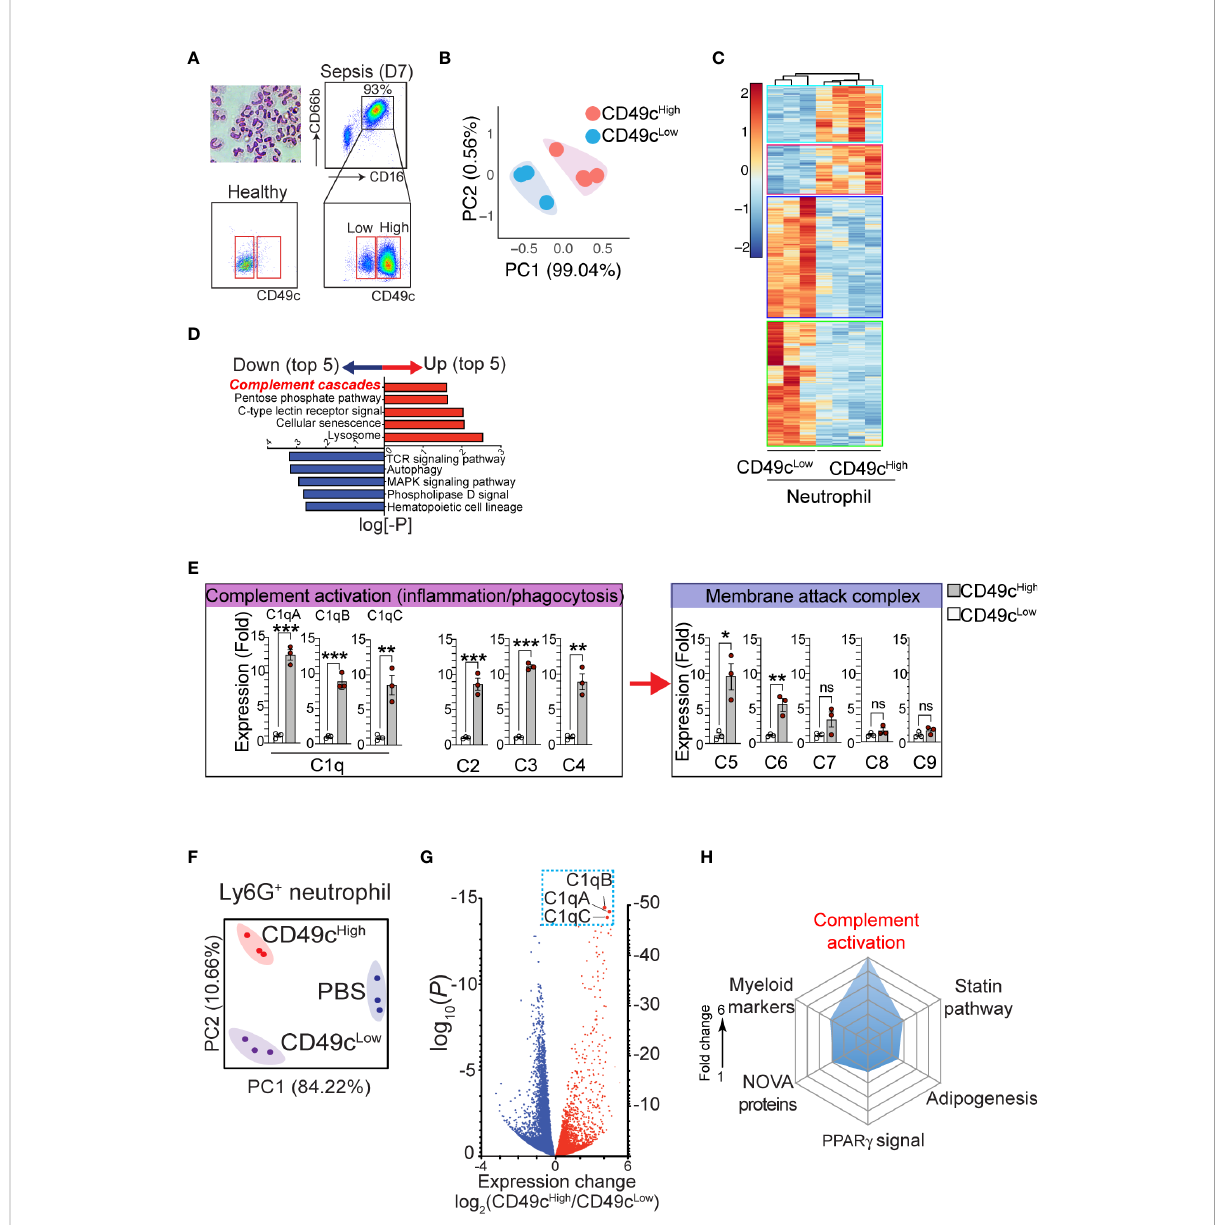
FIGURE 1 The phenotypic heterogeneity in neutrophils from septic patients. (A) , Isolated neutrophils from the blood were stained with hematoxylin and eosin after cytospin and con fi rmed > 99.5% of pure neutrophils by morphology with a multilobed nucleus, without other myeloid cell types such as monocyte and macrophage. The additional gating strategy for CD49c high and CD49c low neutrophil populations in the patient blood is also shown. The pseudo color plots demonstrate CD49c upregulation on septic neutrophils (day 7) compared with neutrophils from a healthy donor. (B) PCA of differentially expressed genes in neutrophil subsets (CD49c high vs. CD49c low ) from septic patients. (C) , Heatmap of RNA- sequencing data from CD49c high (n = 4) versus CD49c low (n = 3) neutrophils sorted from septic patient blood samples. Heatmap represents top 1082 genes chosen from highest 0.25% p-value summary. (D) , Pathway analysis reveals a distinguishable pattern of gene-program changes in neutrophils expressing higher levels of CD49c. Bidirectional plot represents the likelihood (p>0.05) that signaling pathways were enriched ( red ) or reduced ( blue ) in CD49c high vs>. CD49c low septic patient neutrophils. (E) , Expression of the indicated genes in septic neutrophils by qRT-PCR. (F) , PCA of differentially expressed genes in neutrophil subsets in endotoxemic mice or naïve (PBS) mice. (G) , Volcano plot shows comparison of differentially expressed genes in septic neutrophil subsets. Red denotes genes increased and blue denotes genes decreased in neutrophils. (H) , Spider plot using Enrichr GO database showing the top six categories of signaling pathways relating to genes upregulated in CD49c high versus CD49c low septic neutrophils. Measured as a function of fold change of CD49c high over low for likelihood of genes falling into the listed categories. Data are presented as mean ± SEM. Data were analyzed by ordinary one- way ANOVA with Tukey ’ s multiple comparison post-test for b-e (*P < 0.05) or nonparametric Mann-Whitney test for i (**P < 0.01, ***P <